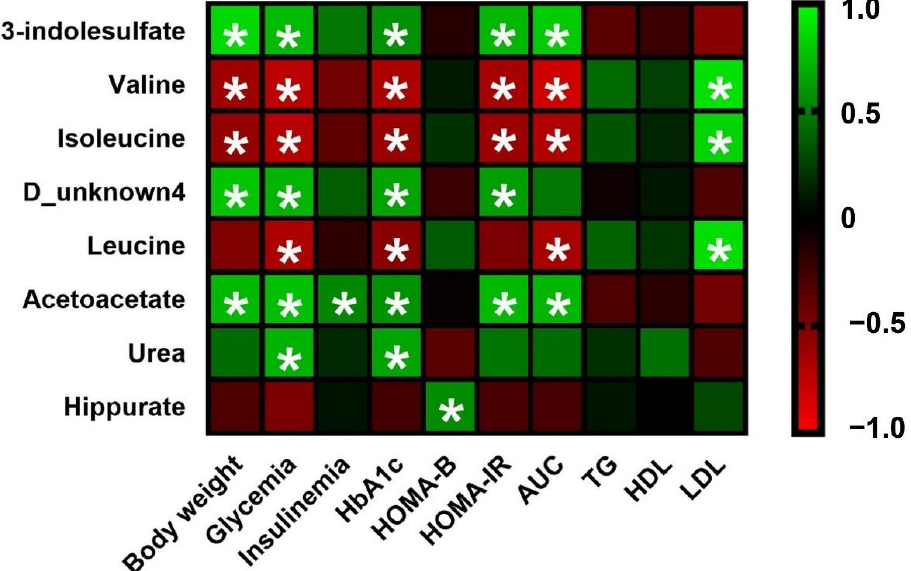
Figure 4. Heatmap of correlation between the main significantly altered urine metabolites and biochemical biomarkers related to diabetes. Pearson correlation values were used for the matrix. Green color indicates a positive correlation, whereas red color indicates a negative correlation; the intensity of the color represents the degree of association. * Represents adjusted p < 0.05.